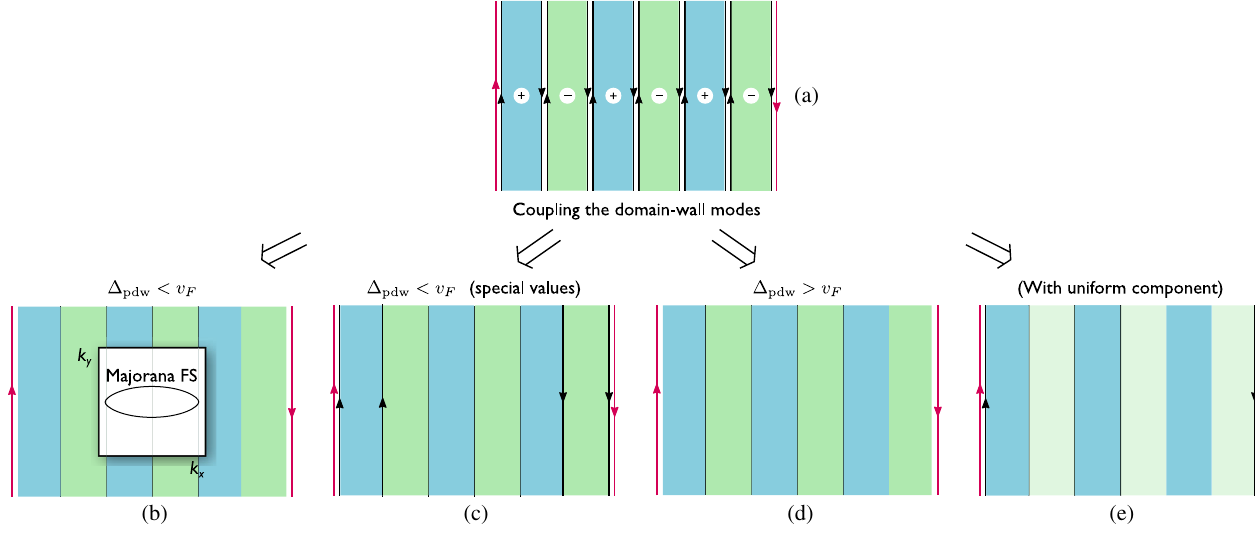
FIG. 1. Illustrationofthe differentquantumHallstatesfromthestripepairing order. The blueandgreenstripsdenoteregions withpositive and negative local pairing order parameters. The black arrows denote chiral Majorana modes, while the red arrows denote chiral bosonic charge modes. Panel (a): Gapless modes on domain walls of the PDWand on physical edges in the limit of vanishingly small localization < v length and negligible couplings between these modes. Panel (b): For the PDW order parameter Δ F , in general, the domain-wall PDW modes form a Majorana FS, while there is an energy gap for charge excitations. Panel (c): For particular values (see Sec. III D 1) of PDW < v C ¼ 2 order parameter Δ F , the Majorana FS shrinks to zero and the fermionic sector becomes gapped. In our model, this phase has PDW > v and Abelian topological order. Panel (d): For Δ F , the fermionic sector becomes trivially gapped, and the resulting quantum Hall PDW < v p ip stateisanAbelianone.Panel(e):TheneutralFSat Δ F becomesgappedwithauniform x þ y pairingcomponentwithnontrivial PDW topology. The resulting quantum Hall state has non-Abelian topological order just like the Pfaffian